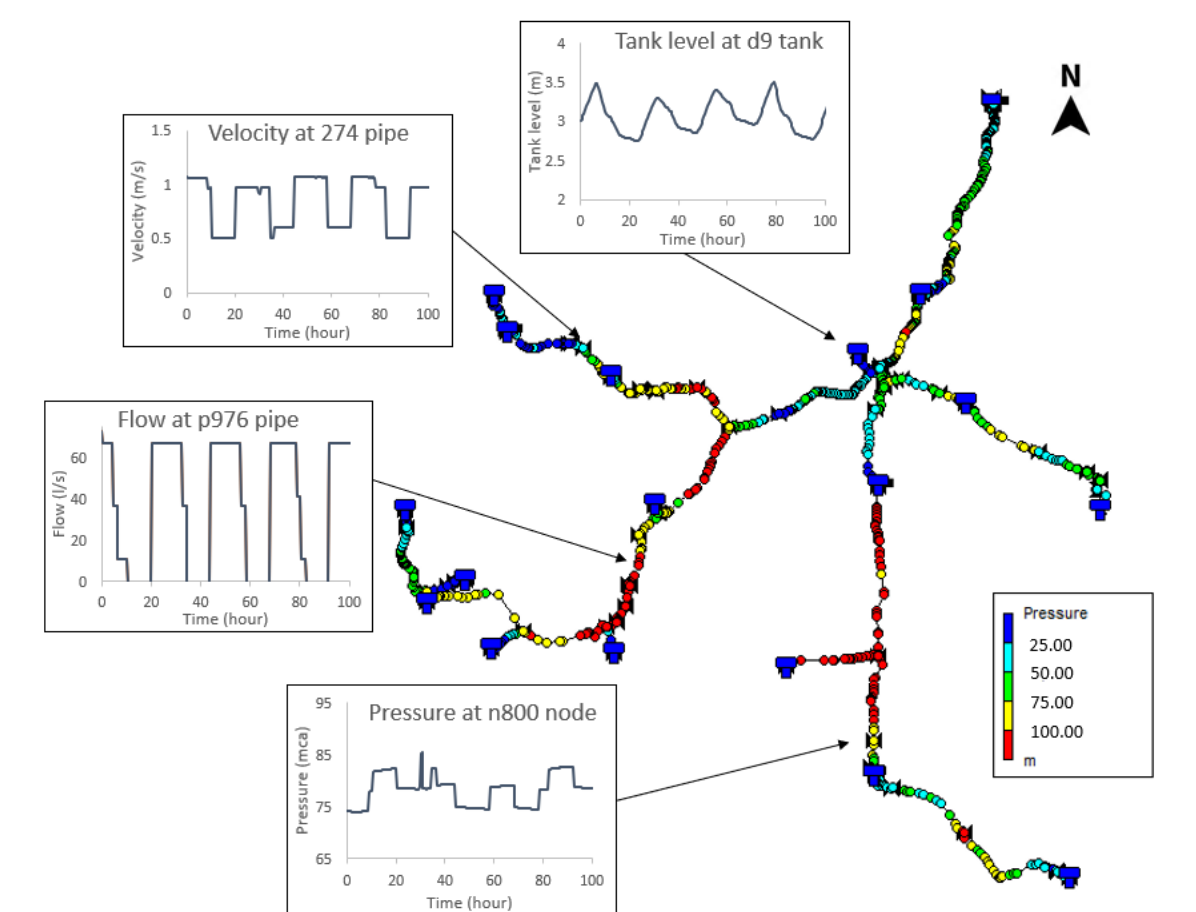
Figure 6. Results simulations of the ES HM (extend simulation period).